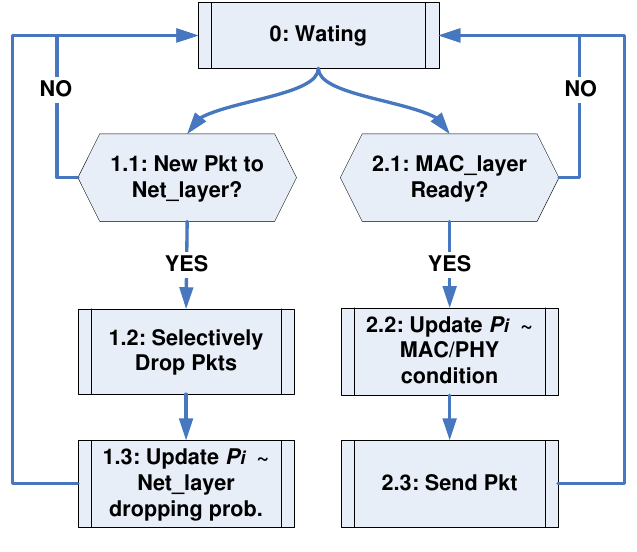
Figure 4. A block diagram illustrating the overall structure of PCC